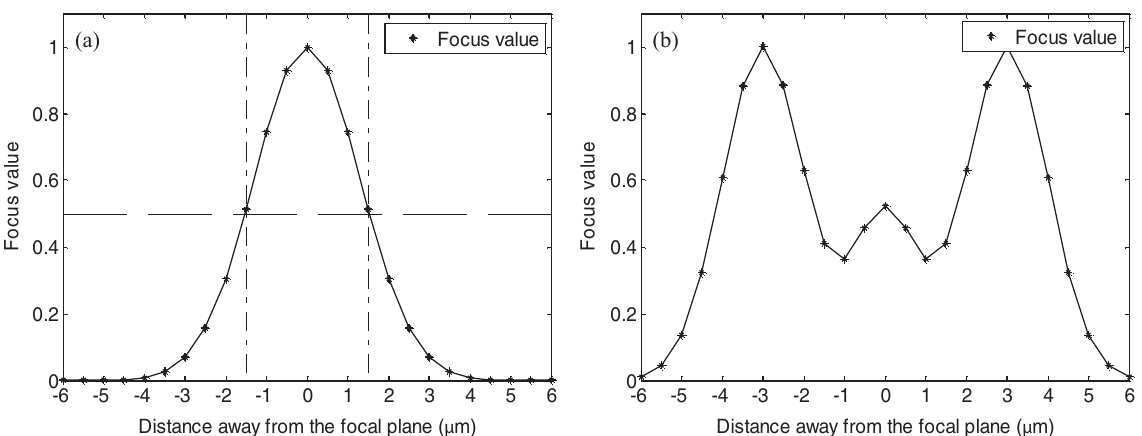
Fig. 1. Examples of an ideal focus curve (a) and a failed focus curve (b). The calculated focus value is plotted as a function of focusing position. The ideal focus curve in (a) is approximated by Gaussian function. It has only one maximum value, which corresponds to the focal plane (0 (cid:2) m). The focus value decreases when the cell moves away. The range where the focus value is above 50% of the maximum is defined as full width at the half maximum (FWHM). Image (b) is a failed autofocus curve. The focus curve has two maximal values, thus the focal position cannot be